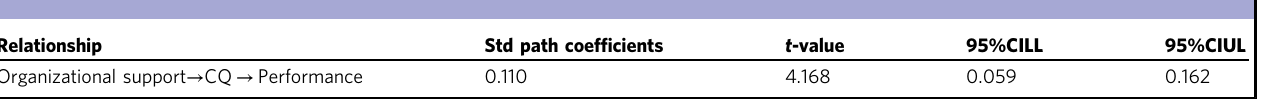
Table 9 Indirect effect veri fi